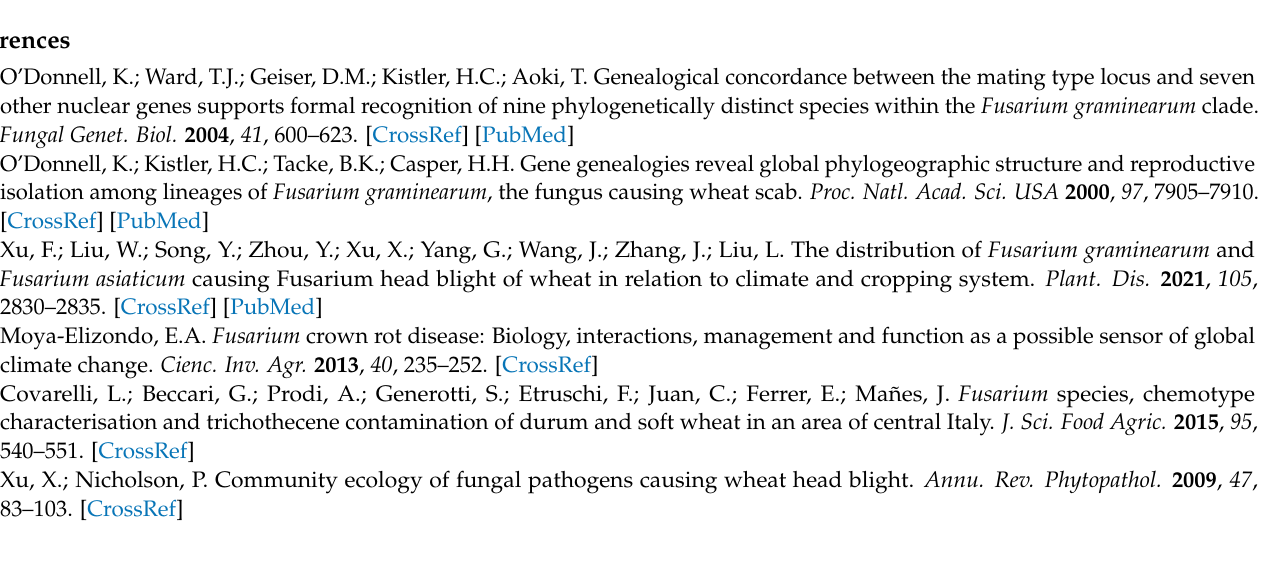
FpV1-Fa; Figure S2: Geographic distribution of FpV1-Fa in 5 cities of China; Table S1: Primers and sequences used in this